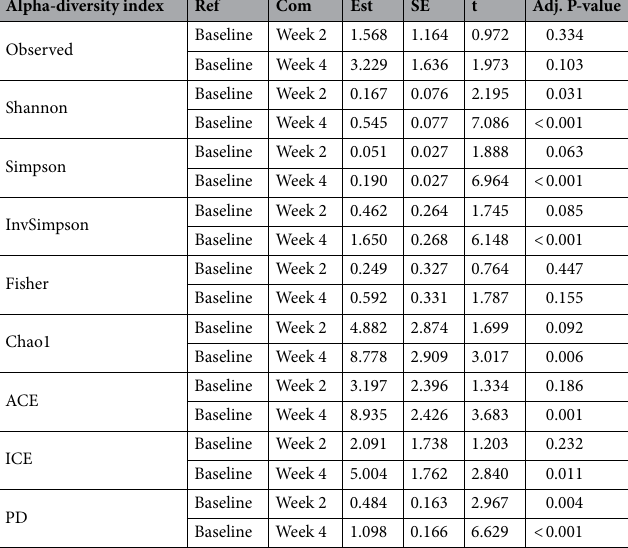
Table 1. The results for comparitive analysis in alpha-diversity (pairwise comparisons). *Ref represents the reference/baseline group, Com represents the comparison group, Est and SE represent the estimated regression coefficient and its standard error, t represents the t statistic value, and Adj. P-value represents the FDR adjusted